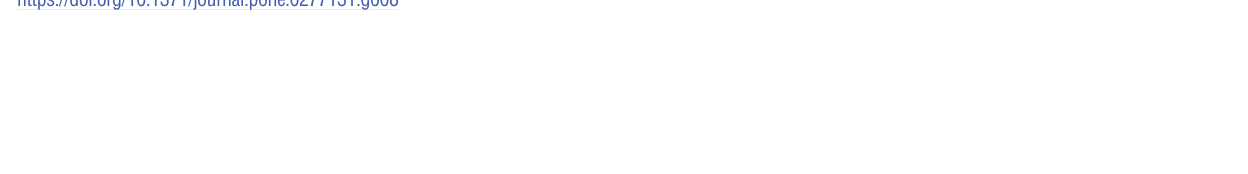
PLOS ONE | https://doi.org/10.1371/journal.pone.0277131 December7, 2022 15 /